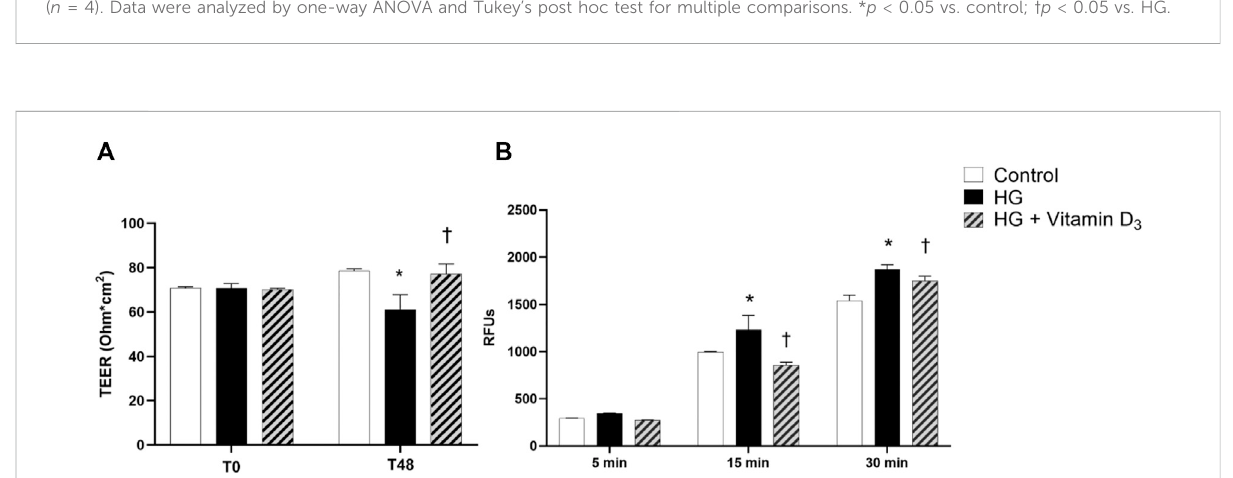
FIGURE 2 VitaminD 3 protectsHRECcellmonolayerfromHG(highglucose)-induceddamage.HRECswerepretreatedwithvitaminD 3 (1 μ M)for24 hand co-treated with HG (40 mM) for 48 h. (A) Vitamin D 3 increased TEER values, which were reduced by HG challenge after 48 h. (B) Measurement of apical-to basolateral Na-Fpermeabilityafter 5,15and 30 min.Valuesarereportedasmean± SD; n =4.Data wereanalyzedbyone-way ANOVA